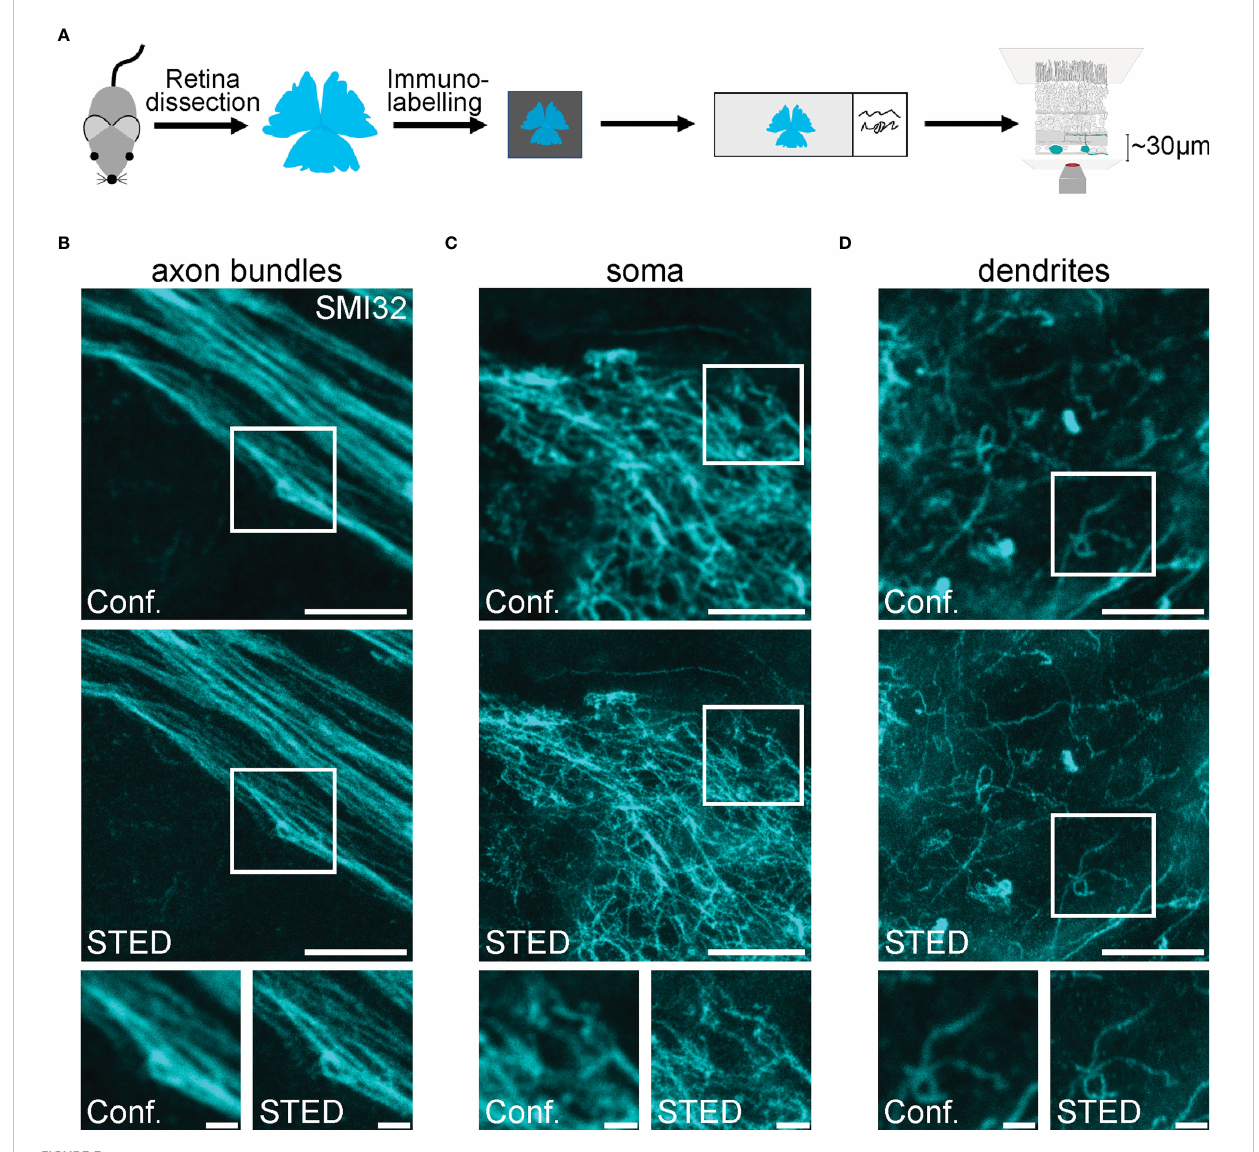
FIGURE 3 Confocal and STED imaging of SMI32-positive retinal ganglion cell structures in the inner retina (A) Scheme of experimental design for imaging RGC structures in the inner retina. Retinae were dissected, mounted on fi lter paper, immunolabelled, mounted on glass slides and imaged. (B-D) . Representative example images of RGCs ’ axon bundles (B) , soma (C) and dendrites (D) imaged in the confocal (conf.) and STED mode at a depth of ~30 µm (axons, soma) and ~50 µm (dendrites). For B, the excitation wavelength was 635 nm, and the dye was STAR635P. For C and D, the excitation wavelength was 635 nm, and the dye was ATTO647N. Scale bars: 5 µm; for insets: 1